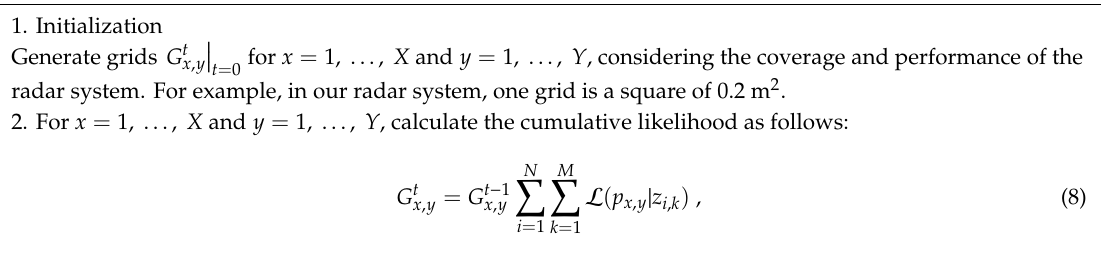
Algorithm 1 Position Estimation with the Proposed